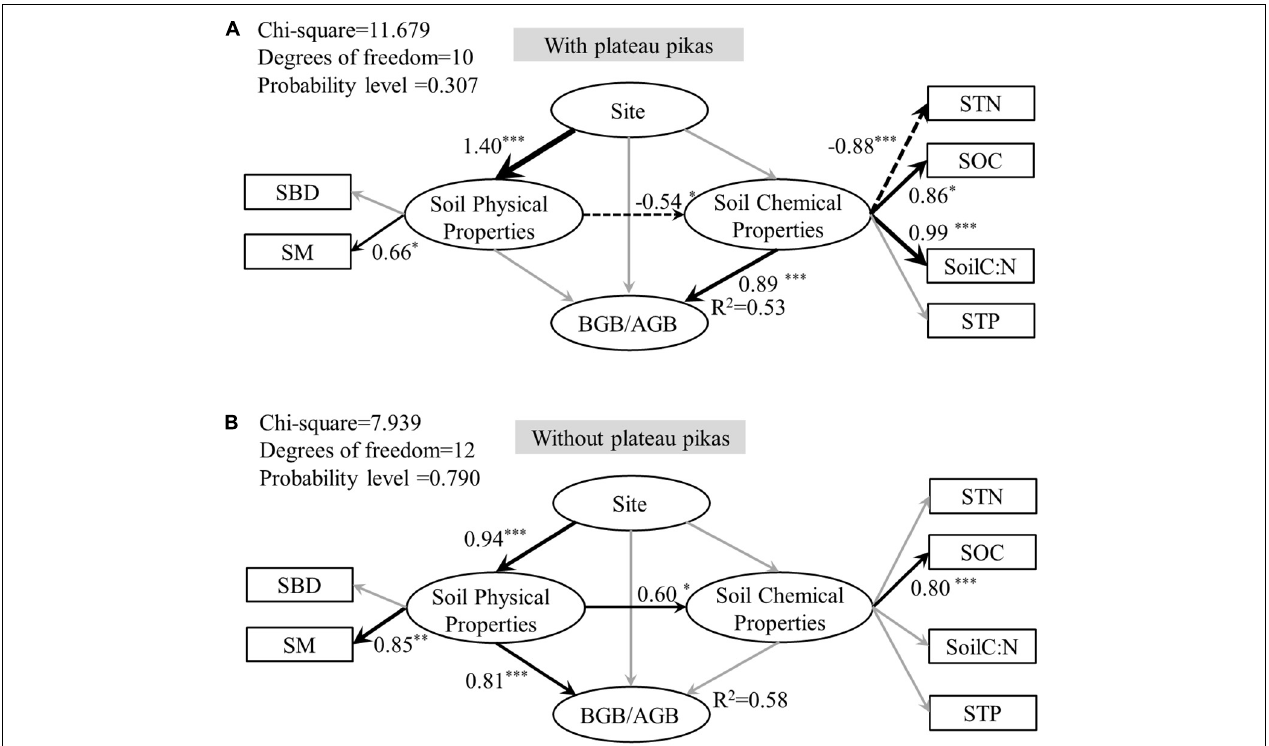
FIGURE 6 | Structural equation model (SEM) exploring the direct and indirect effects and standardized total effects of site, soil physical properties (SBD, SM), and soil chemical properties (STN, SOC, soil C:N, STP) on BGB/AGB in areas with (A) or without (B) plateau pikas. The black arrows indicate that the effect is significant, and gray arrows indicate insignificant effects. Asterisks next to path coefficients indicate p- values. ∗ p < 0.05, ∗∗ p < 0.01, ∗∗∗ p < 0.001. Solid lines and dotted line arrows indicate positive and negative significant relationships, respectively, and arrow thickness indicates the strength of the relationships. STN, soil total nitrogen; SOC, soil organic carbon; Soil C:N, soil carbon/soil nitrogen; SM, soil moisture; SBD, soil bulk density; AGB, above-ground biomass; BGB, below-ground biomass; BGB/AGB, below-ground biomass/above-ground